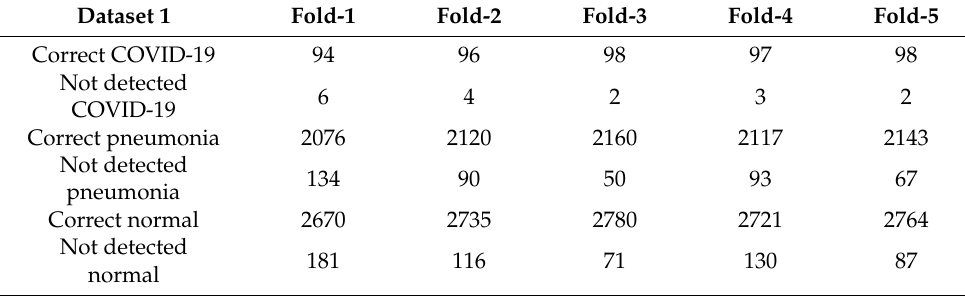
Table 9. Detailed dataset 1 results.